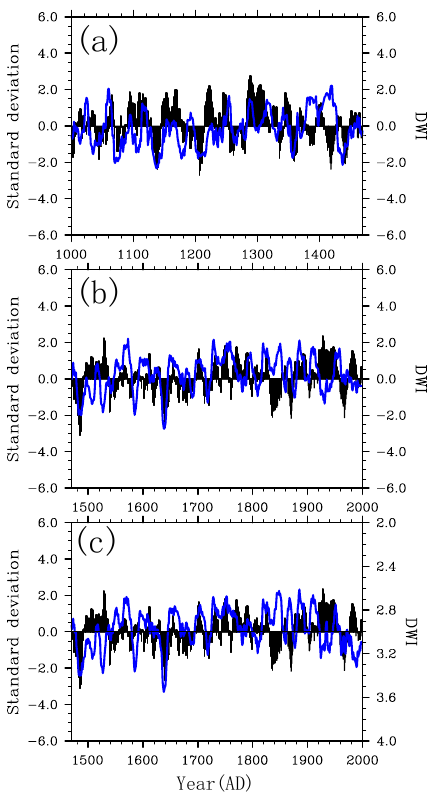
Figure 1. The rainy season precipitation anomaly (May– September) from the modeled data (black bars) and DWI from the proxy data (blue curve) of Zheng et al. (2006) over eastern China during the last 1000years (a, b) . (c) Same as (b) but from the proxy data of Zhang et al. (2003) during the last 530years. All data are 10-year running averages.